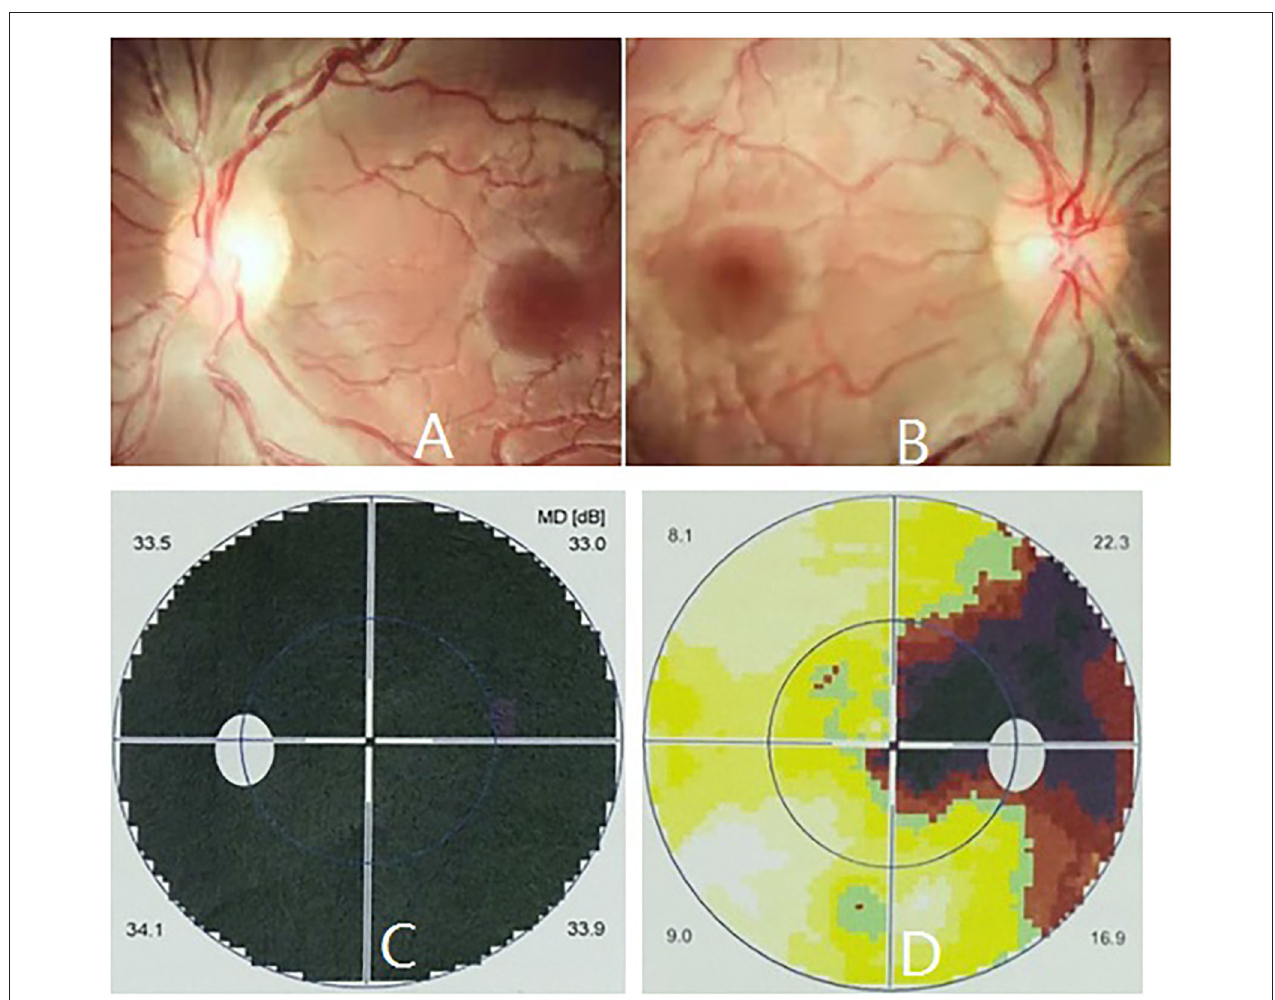
FIGURE 2 | Ophthalmic manifestations of m.13513G > A mutation-related LHON at presentation. Fundus photography revealed pale temporal optic disc with congested nasal optic disc edema in the left eye (A) , and congested optic disc edema in the right eye (B) , respectively. Octopus visual field test showed full field blindness in the left eye (C) and large centrocecal scotoma in the right eye (D) ,